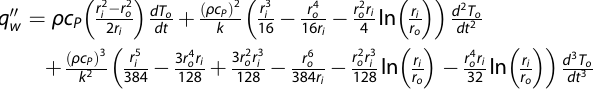
Averaging was done by adding the temperatures and dividing by the number of sensors. Figure 1c illustrates the chilldown curve of all thermocouples (TCs) placed on the tube outer wall according to Fig. 5d, e in the “ Methods ” section. Errors bars are plotted but barely discernable. Three boiling regimes, fi lm boiling (FB), transition boiling (TB), and nucleate boiling (NB), and single- phase convection are separated by three critical points, the Leidenfrost Point (LFP), Critical Heat Flux (CHF), and the onset of nucleate boiling (ONB). The chilldown curve begins in the fi lm boiling regime where the cold liquid entering the warm tube experiences violent boiling. Depending on the local conditions, the fl ow will proceed into dispersed fl ow FB (high quality, low subcooling, low mass fl ux) or inverted annular FB (low quality, high subcooling, high mass fl ux) 40,41 . The high wall surface temperature causes the liquid to completely vaporize before reaching the surface resulting in an inner liquid core and outer annular vapor core. This vapor blanket along the wall insulates the warm pipe from the cold liquid, causing the temperature of the pipe to decrease, albeit slowly. FB is the least ef fi cient quenching mechanism. As the transfer line chills down, the system approaches the LFP, or rewet temperature, where heat fl ux is at a minimum (during boiling). Heat transfer here is a minimum due to the inef fi ciency of heat transfer between cold vapor and wall. LFP is also characterized by the onset of a rapid drop in wall temperature. As shown in Fig. 1c, the LFP occurs at later times for TCs located farther downstream. This trend demonstrates the location of the quenching front as it propagates downstream as chilldown evolves. The fl ow then proceeds and passes quickly through TB, characterized by intermittent liquid contact along the walls. TB ends when liquid is in full contact with the walls at the point of CHF. Heat transfer is a maximum at CHF due to the highly ef fi cient cooling process of boiling. Nucleate boiling follows, where heat is transferred by vapor bubbles formed in surface cavities that are swept away from the tube surface. Depending on the inlet conditions, NB can be liquid-convection dominate or nucleation-dominate 31 . As the wall cools further, the tube inner surface approaches the ONB, characterized as the point at which the system evolves from nucleate two-phase cooling to single- phase liquid convection and an obvious slope change in the